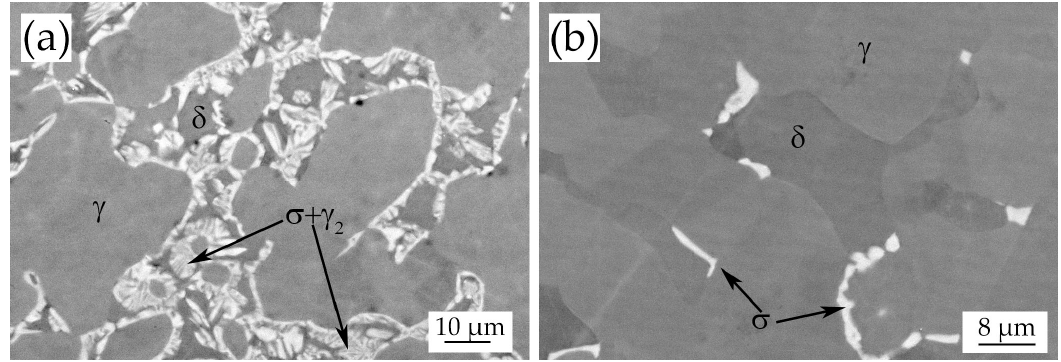
Figure 4. Microstructure after heat treatment at 1000 °C 3 min ( a ), 1080 °C 10 min ( b ).